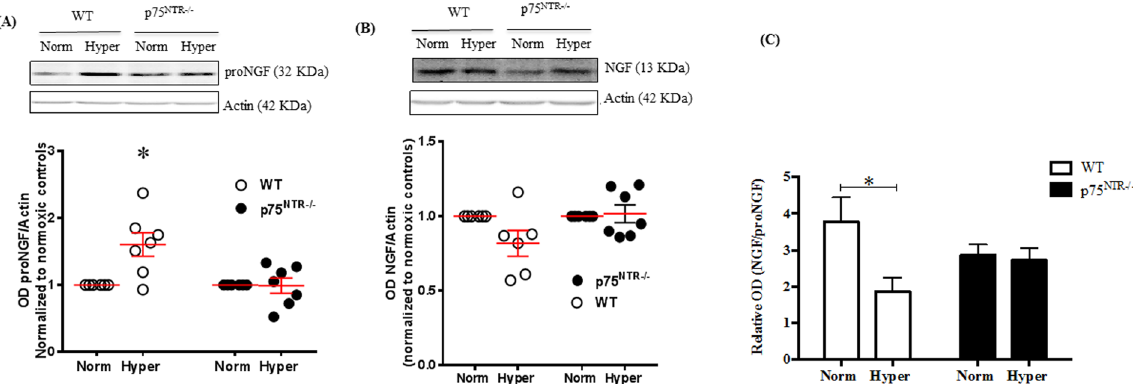
Figure 2. Deletion of p75 NTR attenuated hyperoxia-induced increase in proNGF and decrease in NGF. ( A ) Representative Western blotting and scatter graph showing significant increase in proNGF protein levels in retinas from WT, but not in p75 NTR − / − in response to hyperoxia. ( * significant compared to the rest of the groups using two-way ANOVA, p < 0.05, n = 6–8). ( B ) Representative Western blotting and scatter graph showing a tendency of NGF protein level to be decreased in WT (P = 0.07), but preserved-level in p75 NTR − / − during hyperoxia. ( C ) Bar graph showing significant decrease in of NGF/proNGF ratio in retinas from WT, but not p75 NTR − / − pups in response to hyperoxia ( * significant compared to WT normoxic controls, using two-way ANOVA, p < 0.05, n =